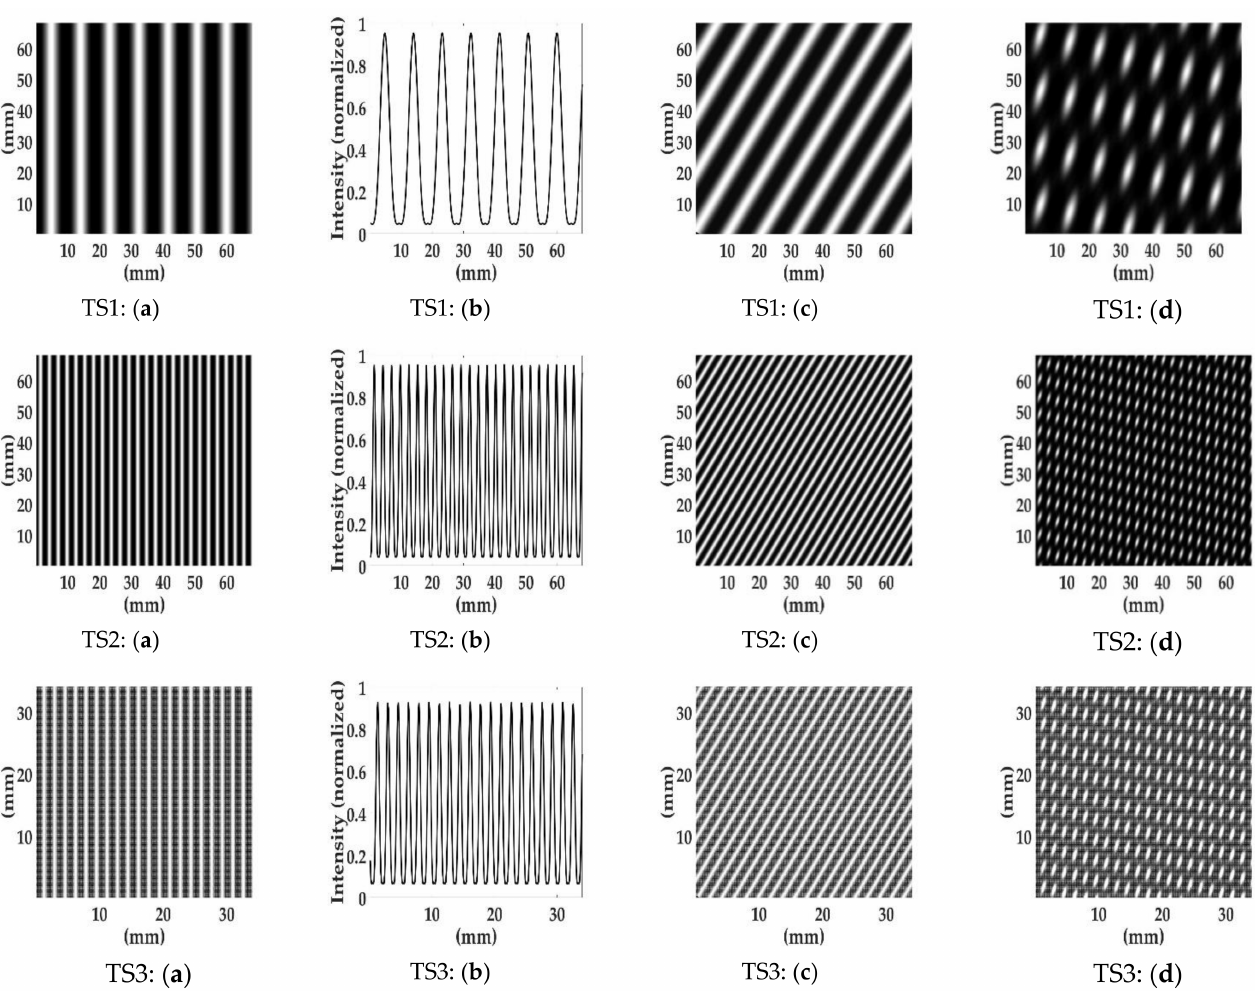
Figure 9. Simulated ( a ) intensities behind the grating (with a period of p 1 = 0.2822 mm) and ( b ) the intensity profile.